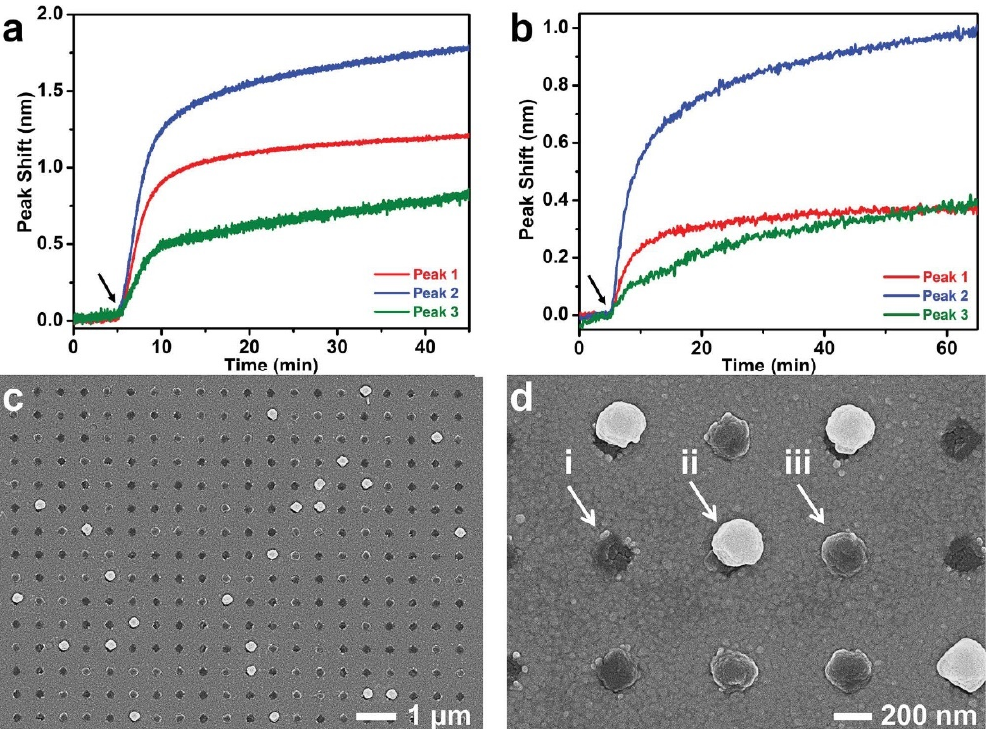
Figure 9. This is a figure. Selective adsorption of virus-like particles into functionalized nanoholes. Nanohole SPR experiments were performed on ( a ) nonfunctionalized and ( b ) mPEG-SH-functionalized nanohole arrays. Spectral shifts as a function of time were recorded for all three transmission peaks. The baseline signal corresponds to aqueous buffer solution. Then, 0.3 mg mL − 1 virus-like particles were added (denoted by arrow) and the particle rupture process was tracked. SEM images obtained at ( c ) 20,000× and ( d ) 40,000× magnification demonstrate that single virus-like particles adsorbed into individual nanoholes on the mPEG-SH-functionalized nanohole array. In part ( d ), arrows indicate the three cases: (i) no particle in the nanohole; (ii) one particle partially inside the nanohole; and (iii) one particle predominately inside the nanohole. Aside from the nanohole positions, nonspecific adsorption of virus-like particles was not observed on the mPEG-SH-functionalized gold surface. Adapted with permission from Jackman et al. [43] Copyright © 2016 Wiley.